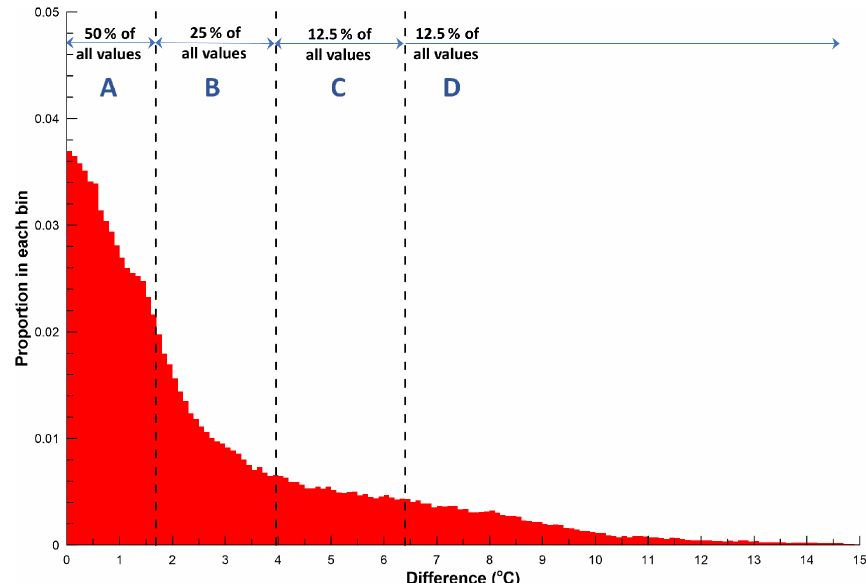
Figure 5. A histogram of the absolute differences between measured and proxy 10min air temperatures (scaled to sea level) across all sites across the entire campaign.